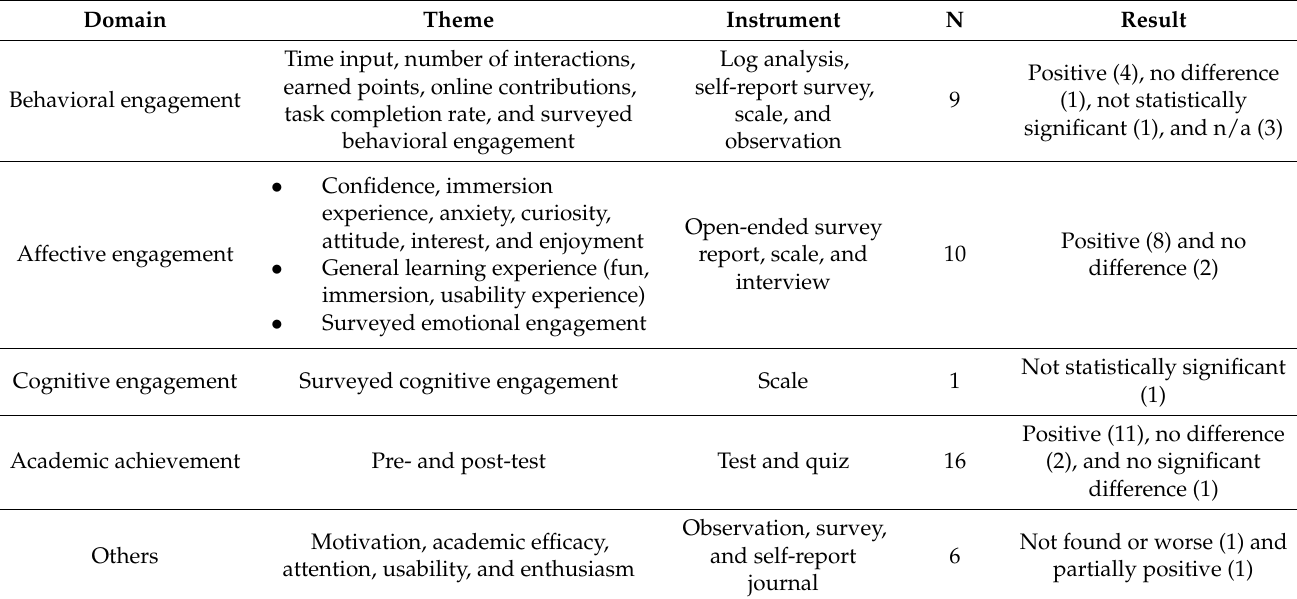
Table 4. Effectiveness assessment and results reported in the selected empirical